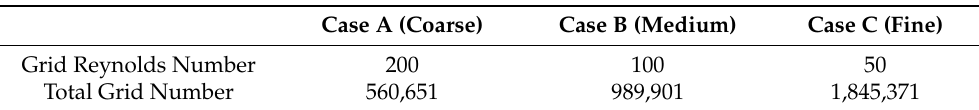
Table 1. Grid resolutions of different cases for the side-by-side propulsion cylinder (Ma = 3.0, H = 40 km).